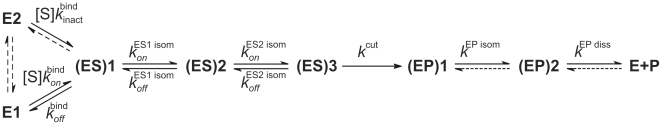
The kinetic scheme describing the interactions of APE1K98A with specific DHU-substrate during NIR.